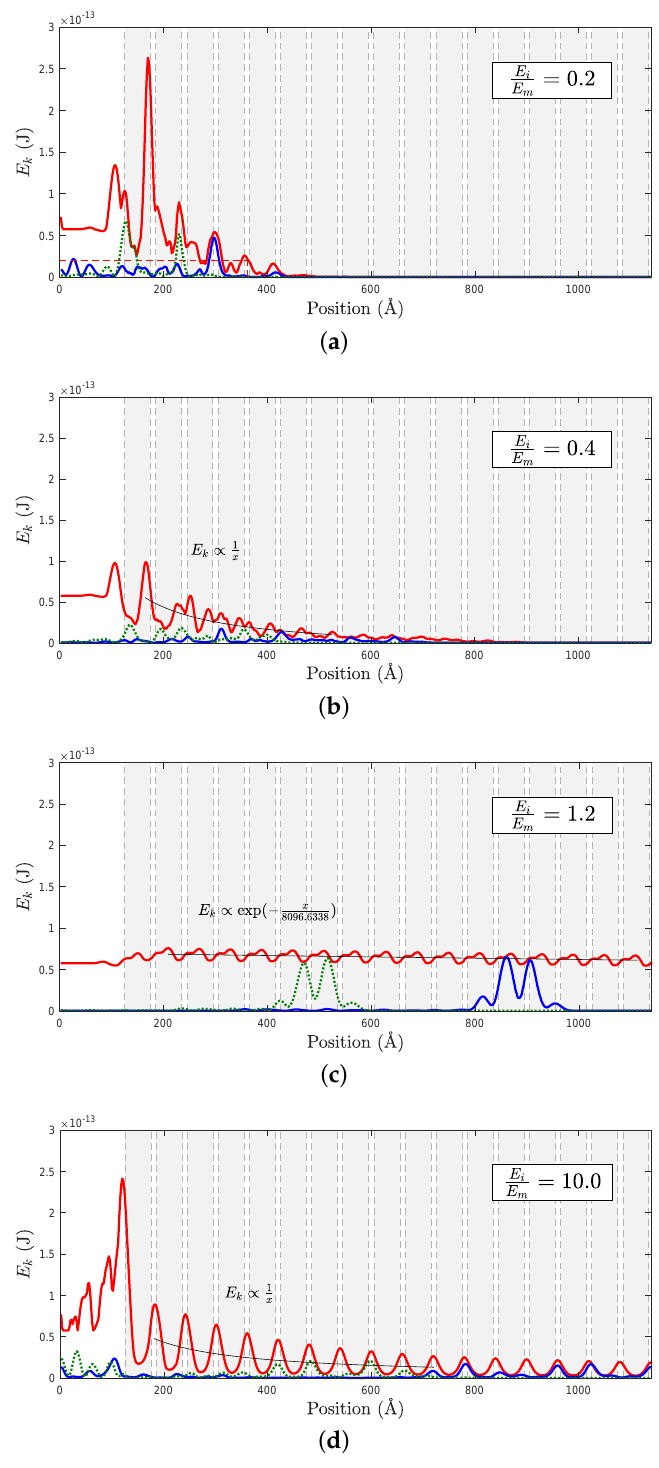
Figure 7. The envelope of kinetic energy for different rigidity contrasts for ω = 5 THz, r = 25 Å is reported as a red line, while the instantaneous distribution of kinetic energy is given at t = 7.9463 ps (green dotted line) and at t = 12.7174 ps (blue line). Gray areas delimited by dotted lines indicate the positions of the circular